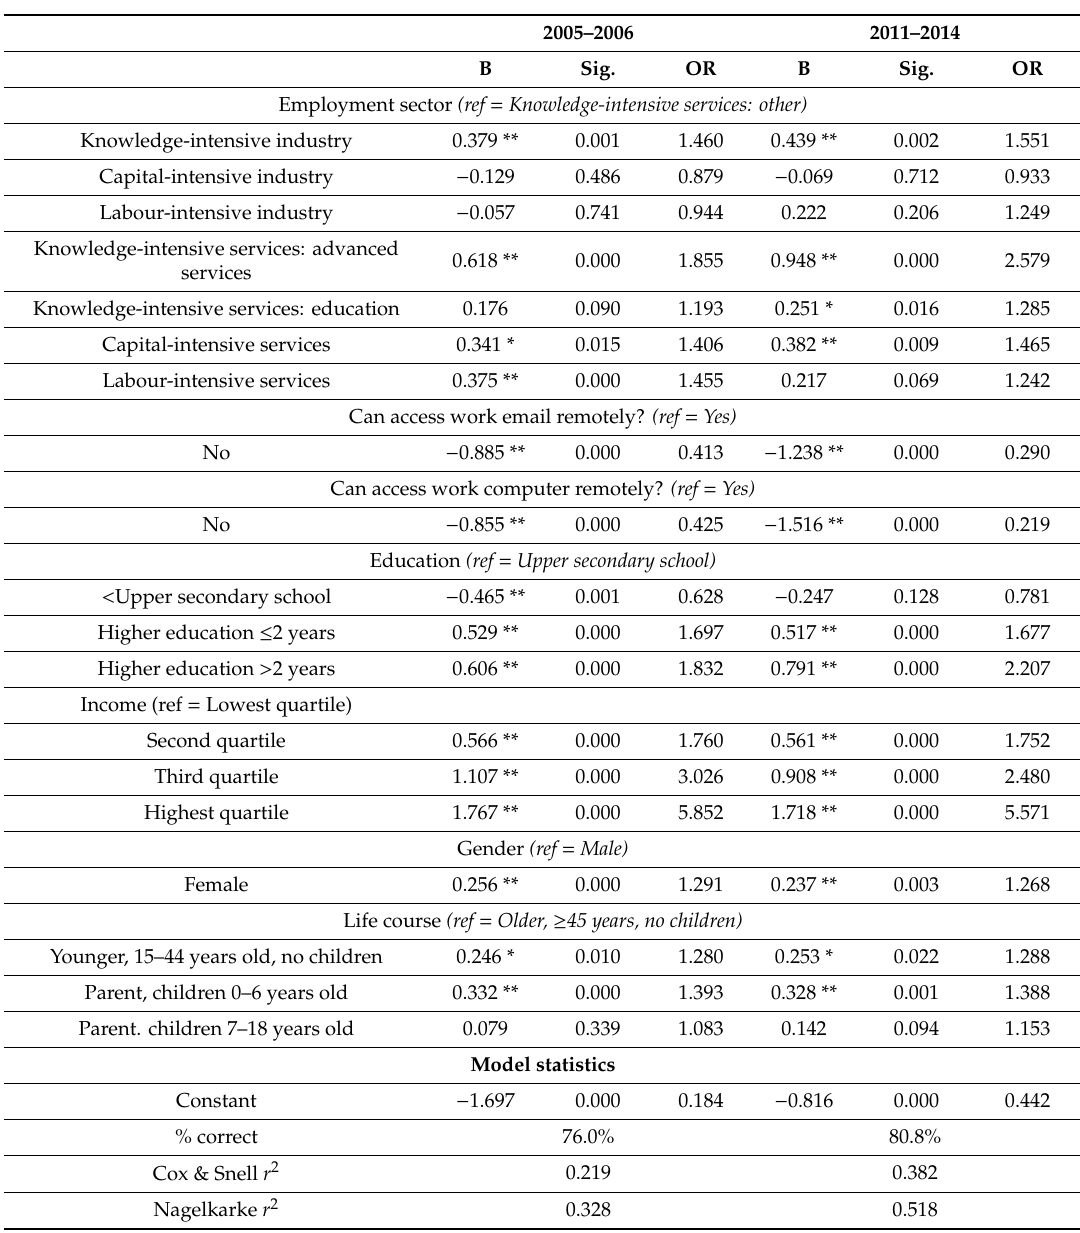
Table 3. Logistic regressions of telework